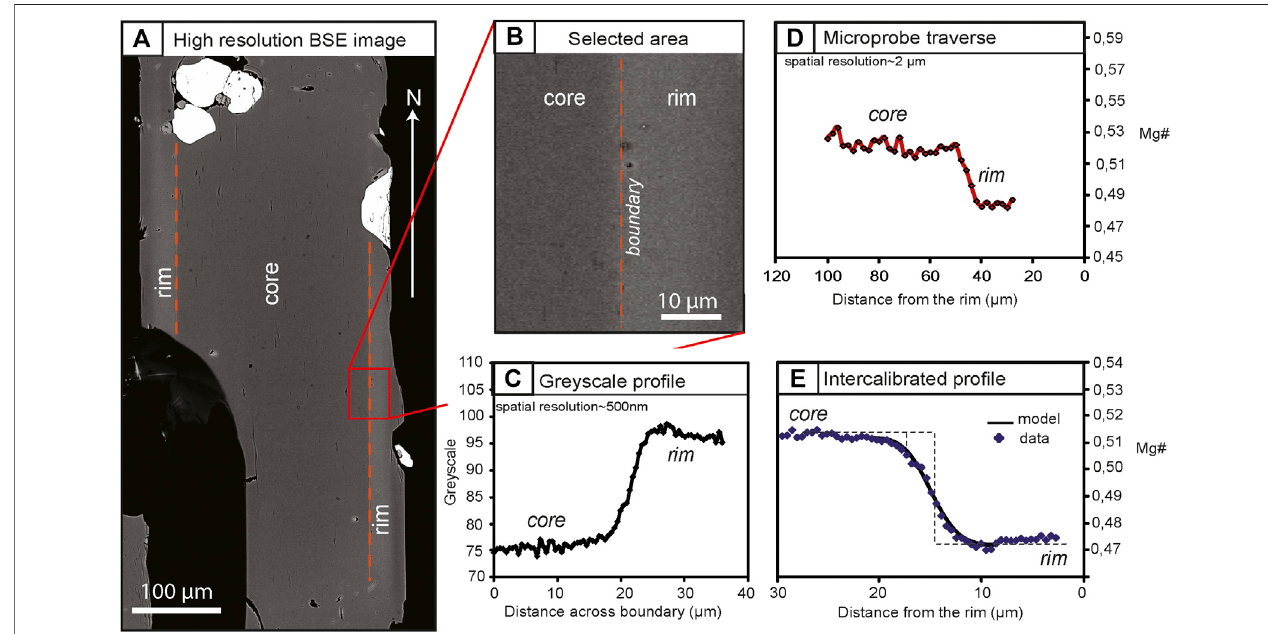
FIGURE 2 | From crystal to greyscale pro fi le. (A) High resolution backscattering image [Back-Scattered Electron (BSE) image] of an orthopyroxene oriented with the c-axis in N-S direction. The core and the rim parts of the crystal are identi fi ed; (B) Detailed BSE image of the main core-rim boundary; (C) Core-to-rim greyscale pro fi le:averagedgreyscalevaluesovertheselectedareaoftheboundary(meanwidth:20 – 50 µm)in (B) usingthefreesoftwareImageJ; (D) MicroprobeMg#(Mg# (cid:1) Mg/ [Mg + Fetot)] core-to-rim traverse over the selected area of the crystal. Spatial resolution is of 2 µm. Uncertainty: 0.2 mol% on Mg; (E) Final calibrated pro fi le and modeled pro fi le resulting from the intercalibration of Back-Scattered Electron greyscale values on microprobe analyses, assuming a step function as the initial condition (dashed lines). Data are presented in Supplementary Tables S2, S3 in supplementary material.